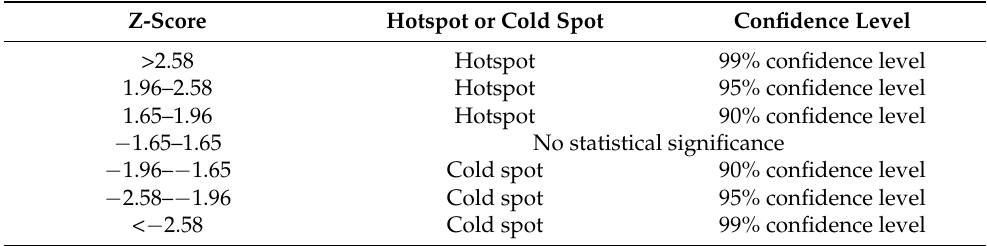
Table 1. Classification and statistical significance of hotspot and cold spots based on